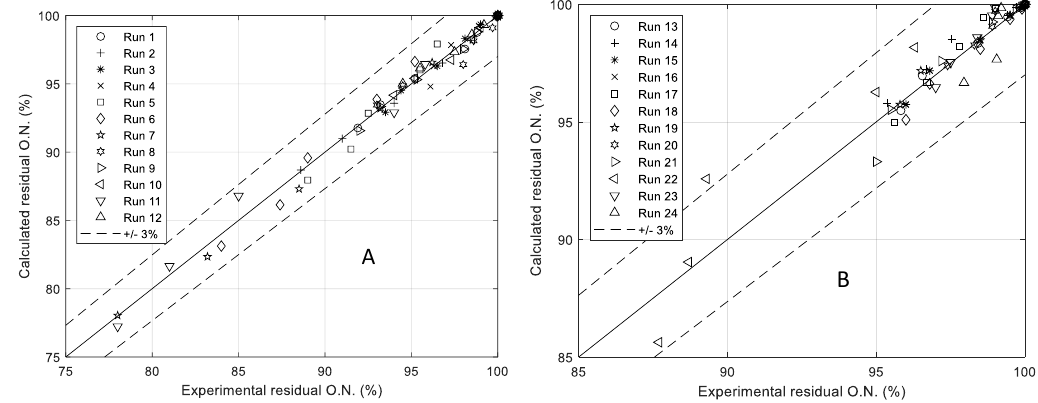
Figure 11. ( A , B ) A is the parity plot related to all the runs performed in the presence of H 2 SO 4 (runs 1–12). B is the parity plot related to all the other performed runs (runs 13–24 of Table 1).